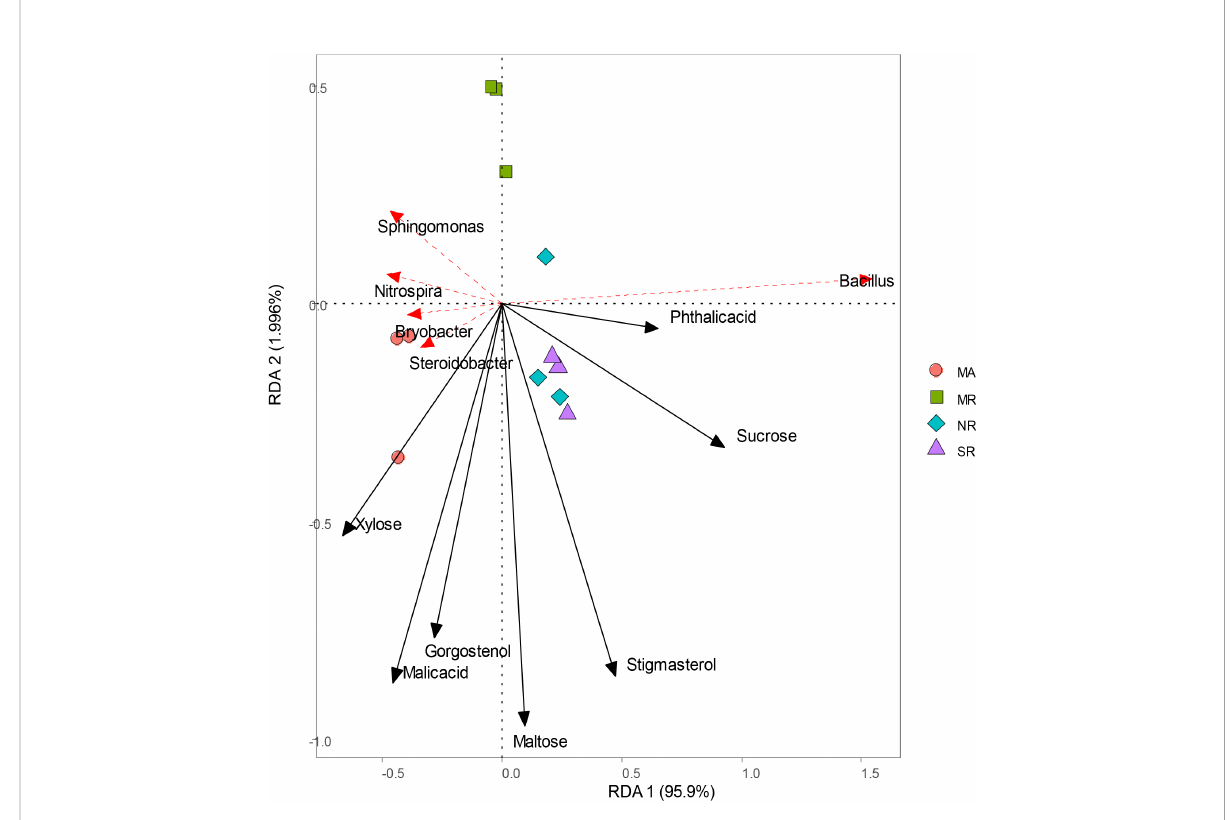
FIGURE 7 Redundancy analysis of soil microorganisms (genus) and main differential metabolites under different intercropping